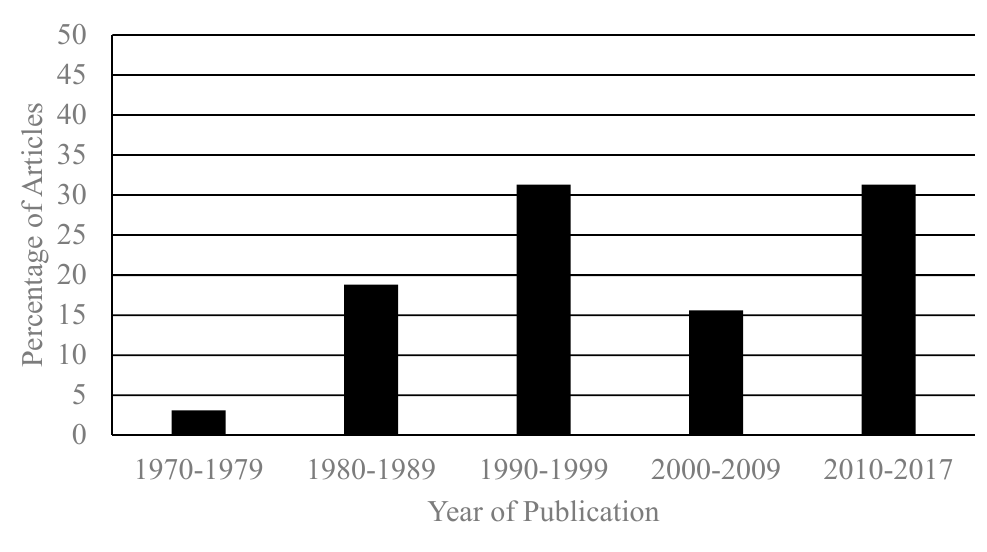
Figure 1. Percentage of reviewed articles published in each year.